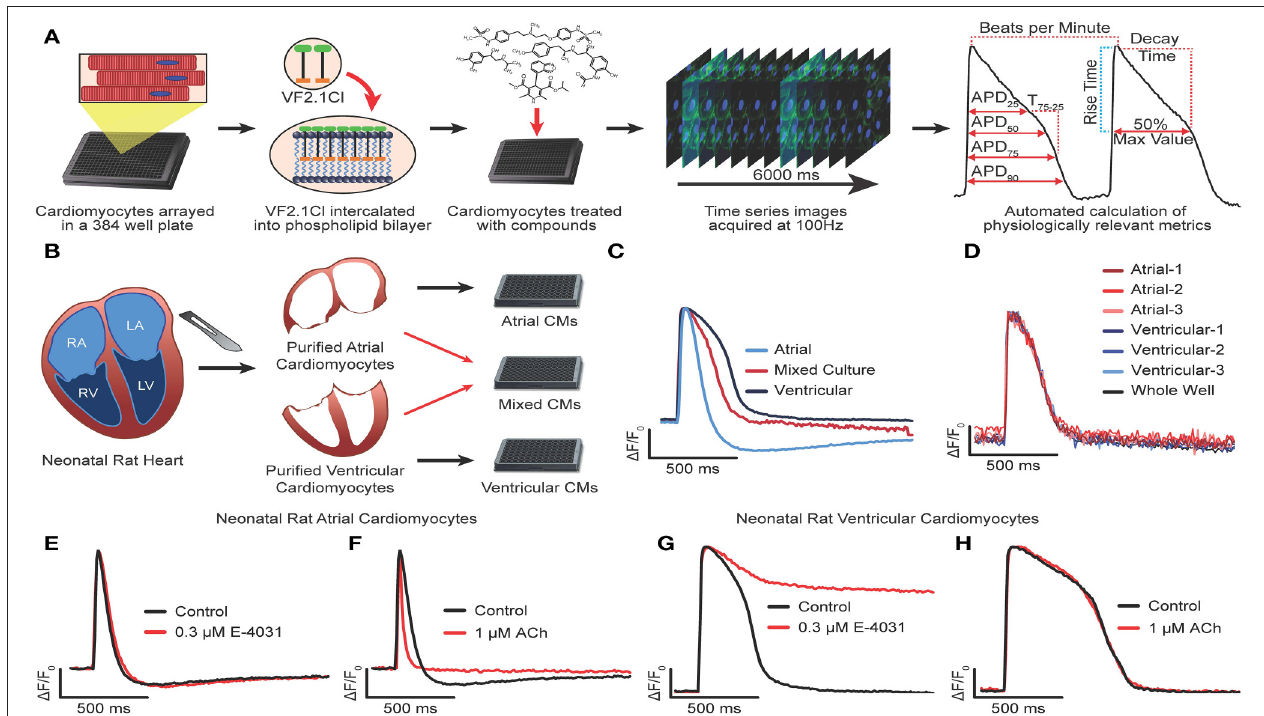
FIGURE 1 | Development and optimization of high throughput optical recording of VF2.1.Cl in cardiomyocytes. (A) Schematic of workflow for HTS transmembrane potential assay. VF2.1.Cl, VoltageFluor2.1.Cl voltage sensitive dye. (B) Schematic of workflow to isolate neonatal rat CMs from the atria and the ventricles and plated either in isolation or as a 1:1 mixture. (C) Normalized 1 F/F 0 vs. time plots (100Hz) generated from wells containing isolated neonatal rat atrial CMs, isolated ventricular CMs or a mixed culture of rat atrial and ventricular CMs paced by electric field stimulation at 0.3Hz. (D) Overlay of normalized 1 F/F 0 vs. time plots generated from individual clusters atrial and ventricular CMs as well as from the whole well average 1 F/F 0 vs. time. (E–H) Normalized 1 F/F 0 vs. time plots for isolated atrial (E,F) or ventricular (G,H) CMs treated with 0.3 µ M E-4031 (E,G) , 1 µ M acetylcholine (F,H) as compared to an untreated well. Scale bars indicate time (500 ms) and 1 F/F 0 (25% of the maximal obtained in each